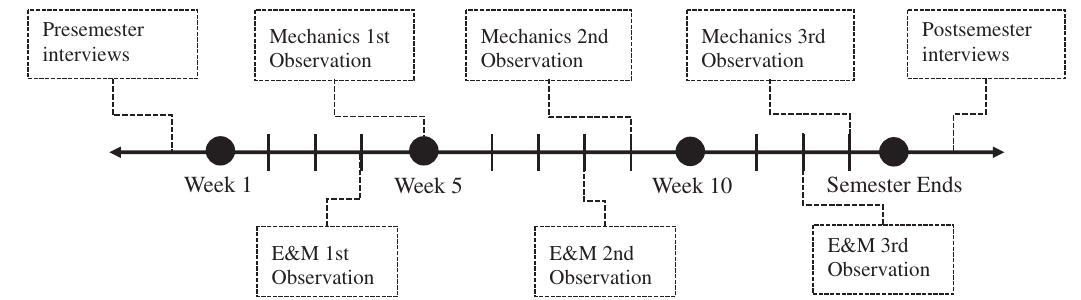
FIG. 2. The research timeline for interviews